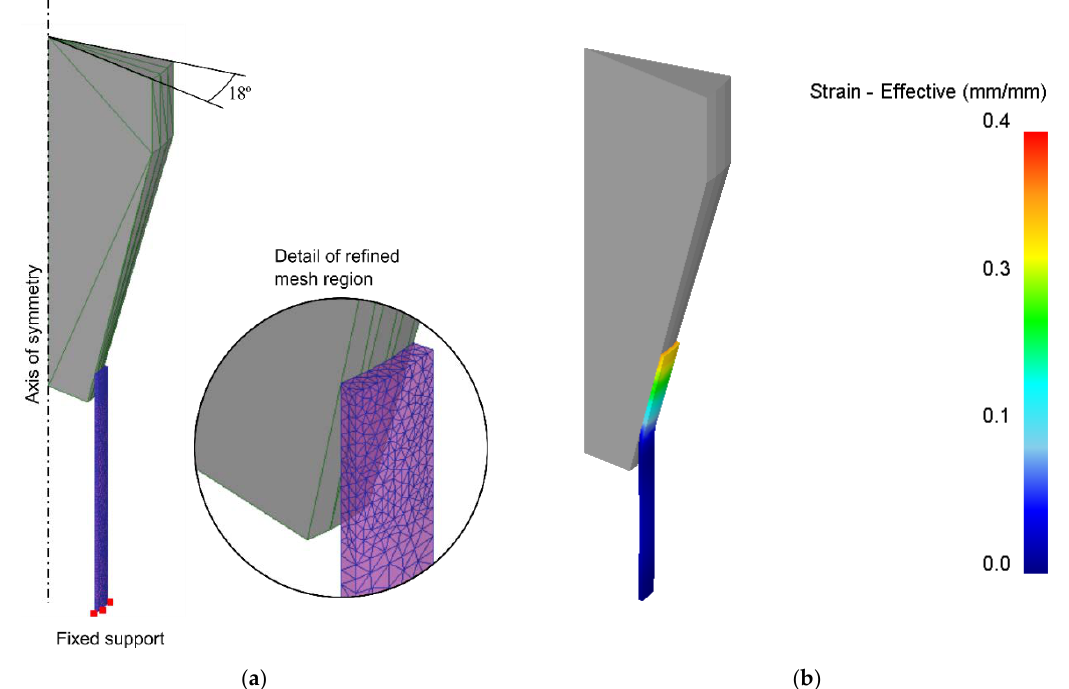
Figure 6. Finite element modeling of conventional tube expansion with a rigid tapered conical punch having a semi-angle of 15°. ( a ) Initial mesh with a detail of mesh refinement and ( b ) predicted distribution of effective strain at the end of the process.